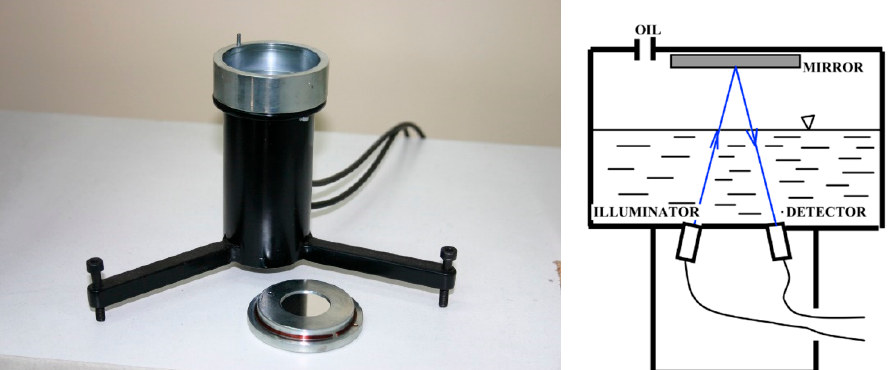
Figure 5. The calibrator image and work diagram.